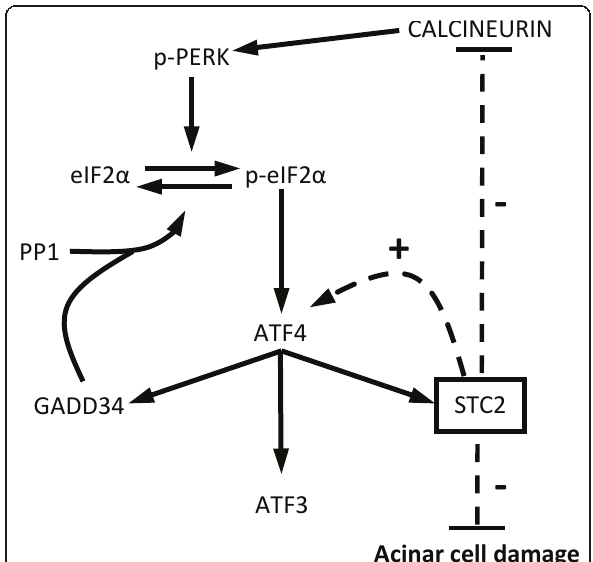
Figure 7 Schematic pathway showing a possible role for STC2 in affecting the PERK signalling pathway . The increased accumulation of ATF4 leads to increased expression of GADD34, ATF3 and STC2. Elevated levels of STC2 can alter both PERK phosphorylation and ATF4 levels through as yet undetermined mechanisms (dashed arrows), as well as promote reduced damage during pancreatic injury. Whether this protective effect of STC2 is a normal function of the protein needs to be